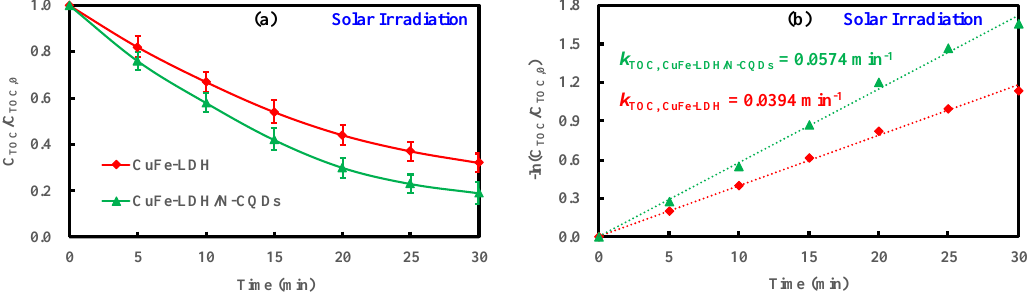
Figure 5. ( a ) Total organic carbon (TOC) variation of MB solution and ( b ) pseudo-first-order kinetic fit for TOC removal during the photo-Fenton process. Error bars represent standard deviation of triplicate runs.